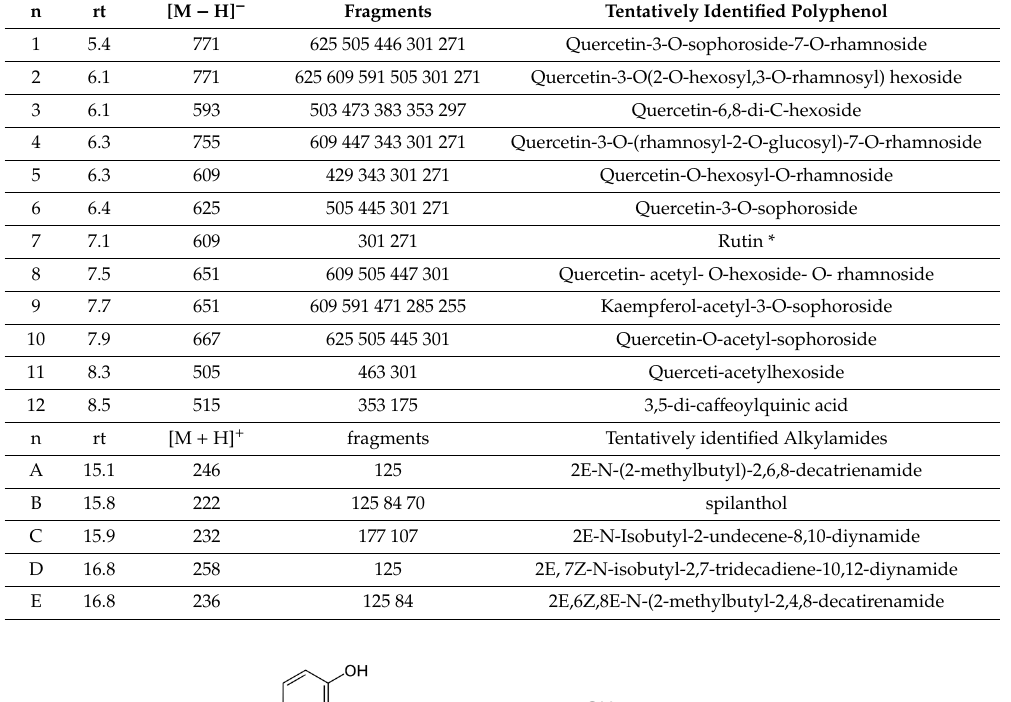
of compounds was obtained comparing spectral data with literature and reference when available. Figure 5. Chromatogram of A. oleracea extract at 254 nm and enlargements at 350 nm of polyphenol signals and at 230 nm of alkylamide signals .